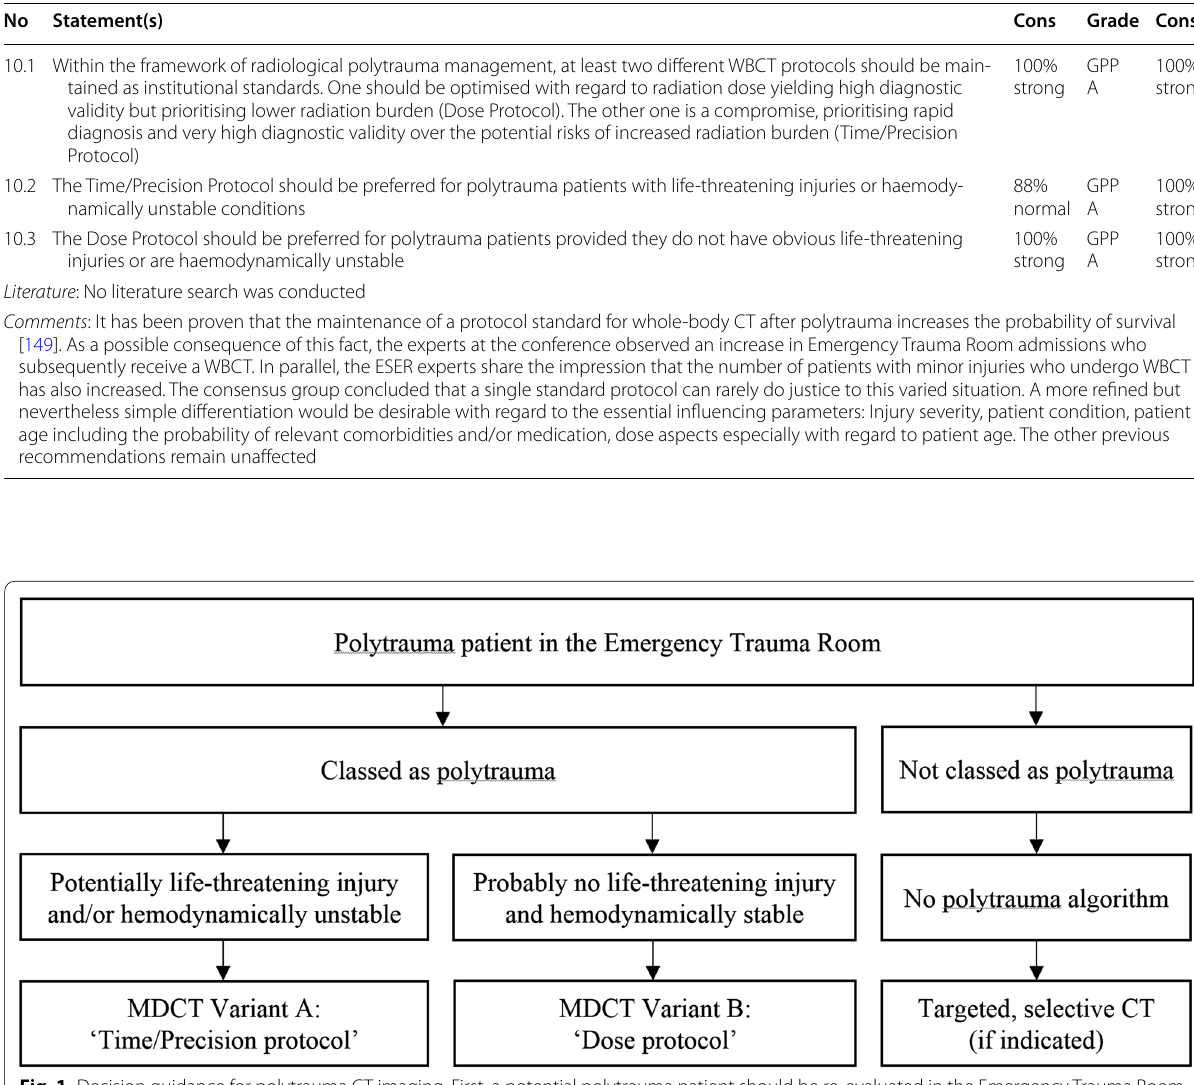
Table 19 Section 10: Summary: A proposal for two WBCT—Protocols in the Trauma Care Key question : Is one standard CT protocol sufficient?